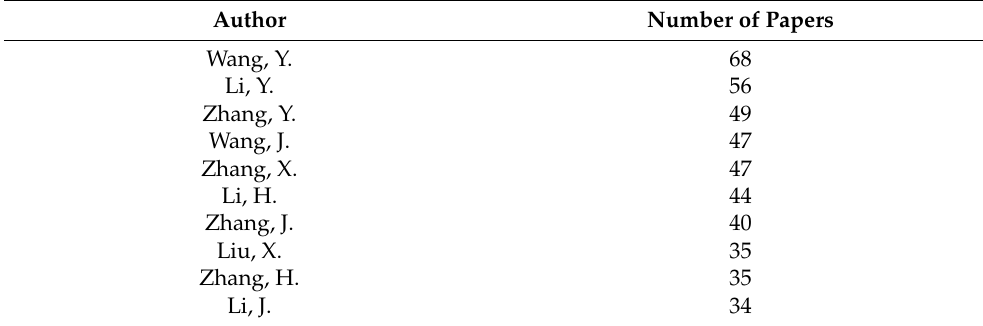
Table 4. Top 10 authors who published indexed papers on environmental sustainability, environmen- tal impacts and environmental aspects related to circular economy in the steel life cycle. The results derived from the analysis of articles identified during the first round of bibliographical research and refer to works published between 2019 and